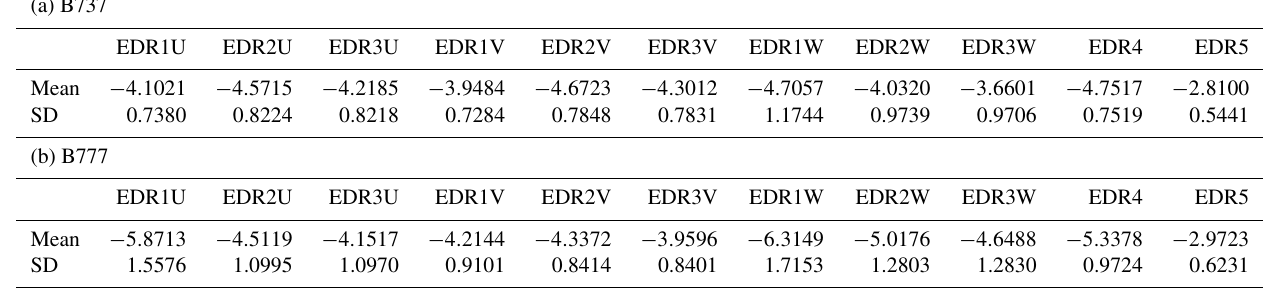
Table 1. Values of the mean and standard deviation (SD) of the natural logarithms of EDRs computed from (a) B737 and (b) B777 QAR datasets.